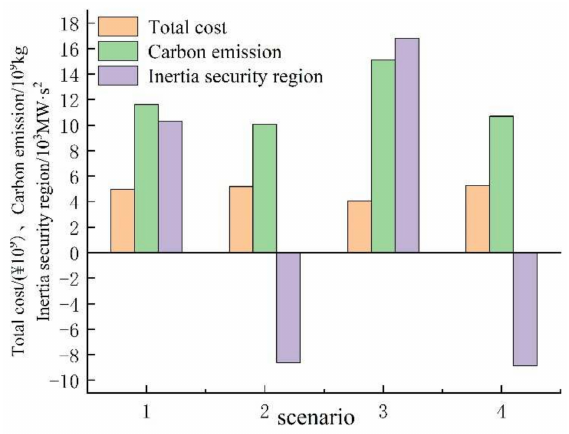
Figure 21. Characteristics of different